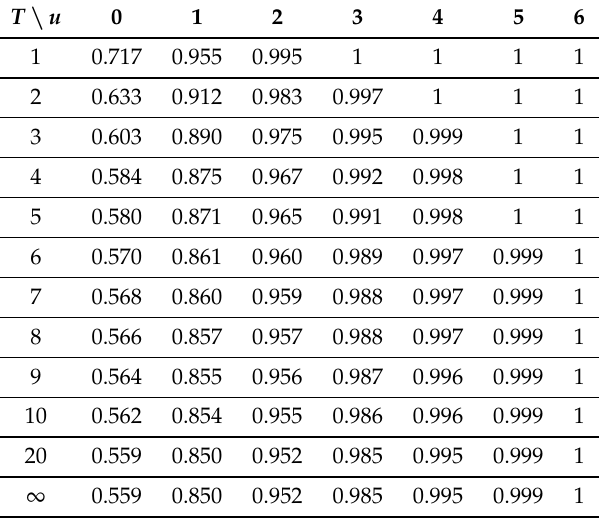
Table 8. Values of survival probabilities for the model with Poissonian random variables (r.v.s) of Example 4.